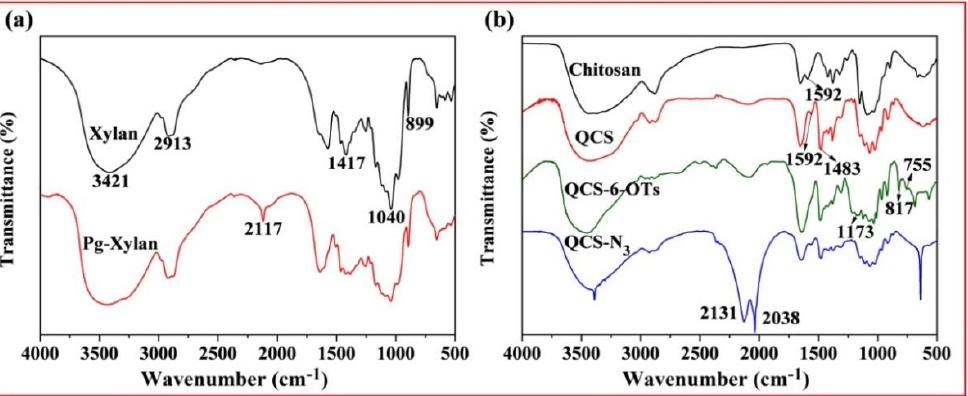
Figure 2. FT-IR spectra of ( a ) original xylan and Pg-xylan and ( b ) chitosan, QCS, QCS-6-OTs and QCS-N 3.